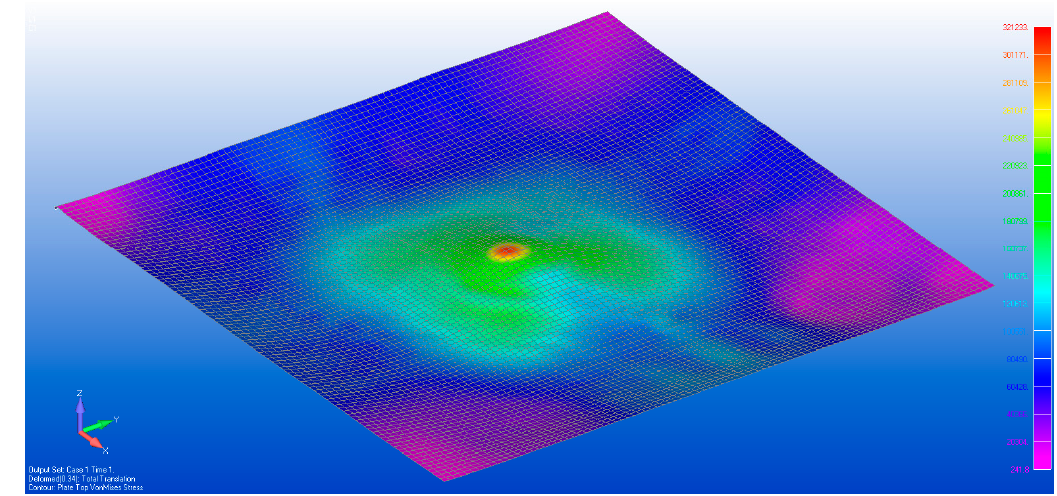
Figure 30. The von Mises stress caused by tripod support.